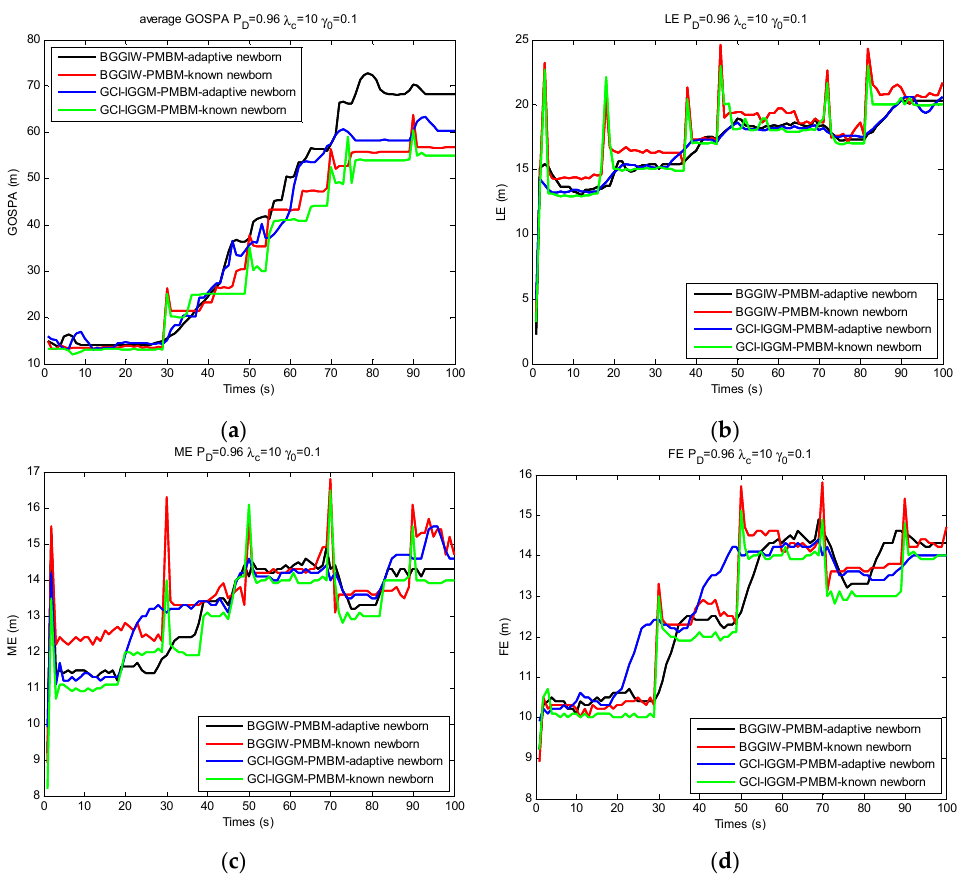
Figure 10. Performance comparisons of GCI–IGGM–PMBM and BGGIW–PMBM with newborn distribution: ( a ) GOSPA; ( b ) LE; ( c ) ME; ( d ) FE.